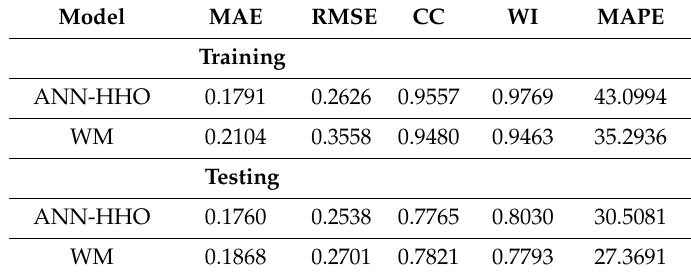
Table 5. Comparison of performance metrics of hybrid ANN-HHO model with Wu Model (WM). Model MAE RMSE CC WI MAPE Training ANN-HHO 0.1791 0.2626 0.9557 0.9769 43.0994 WM